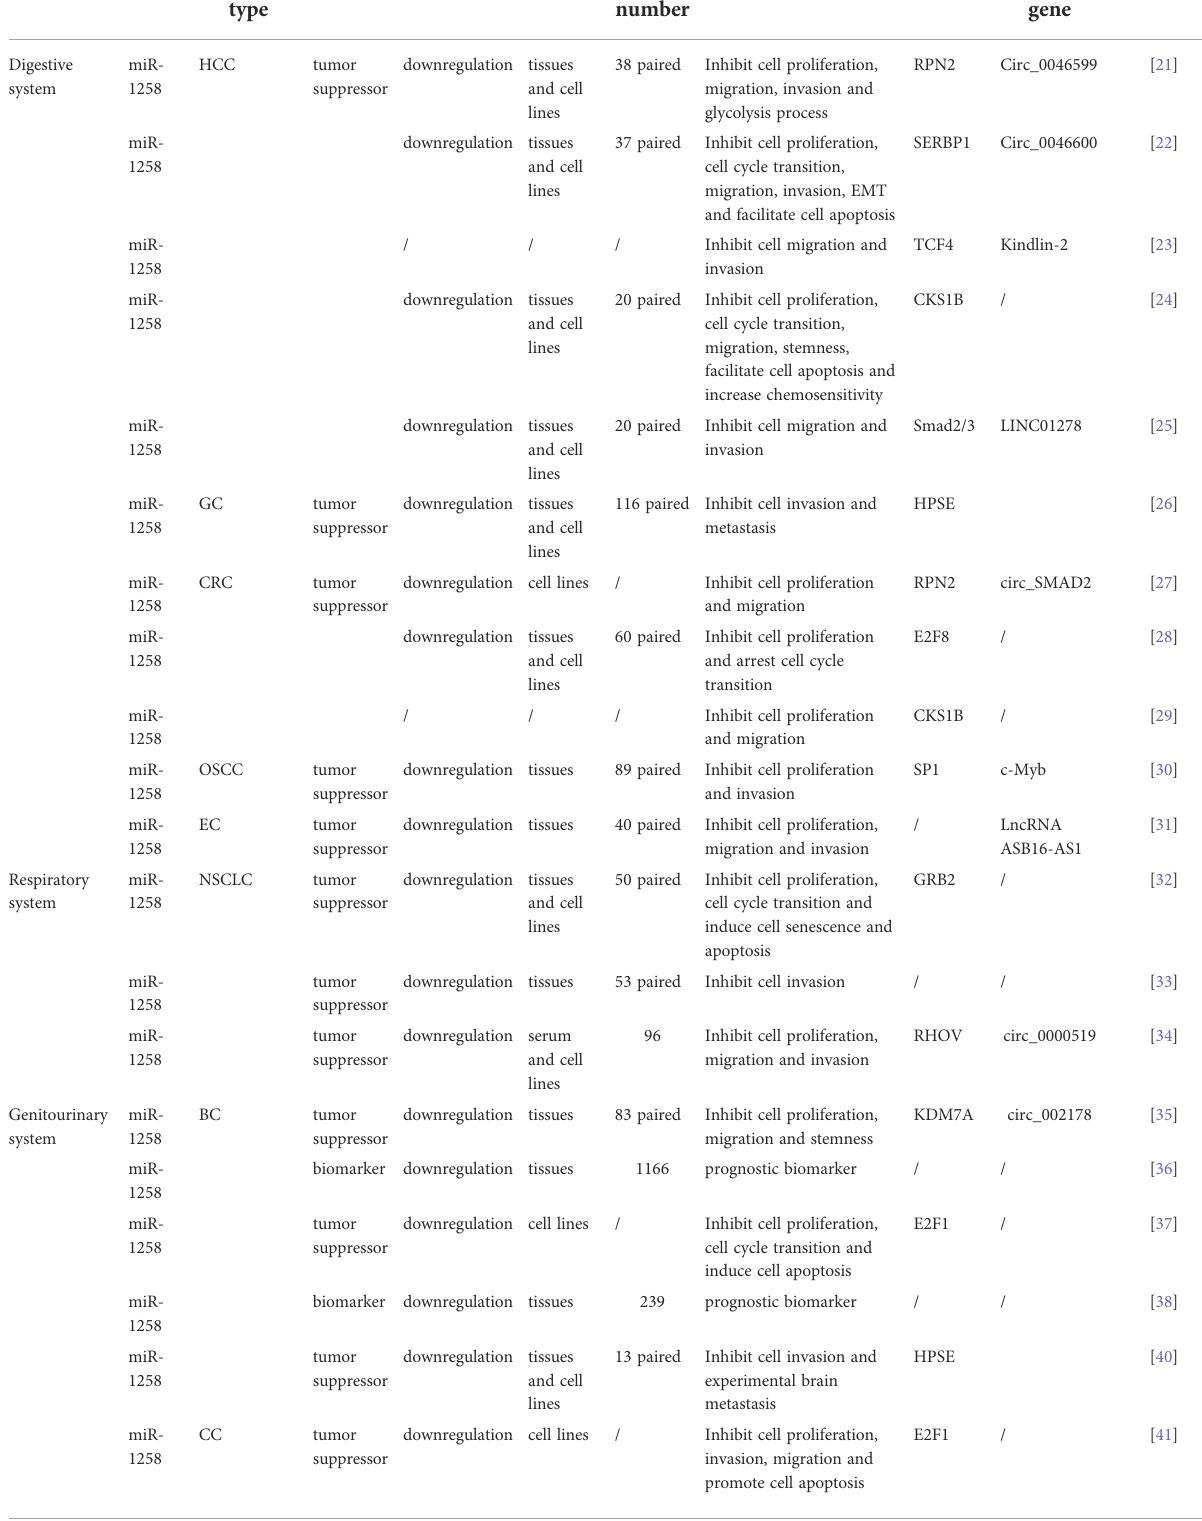
TABLE 1 Expression pro fi les of miR-1258 in human